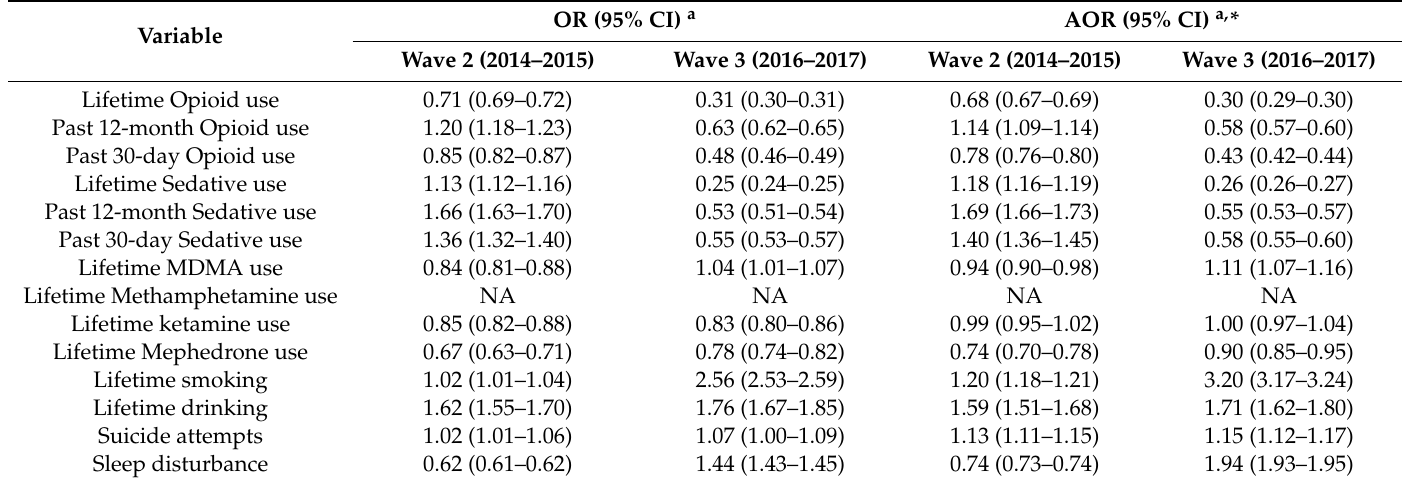
Trends in health-risk behaviors among Chinese adolescents: univariable and multivariable logistic regression showing time associated with health-risk